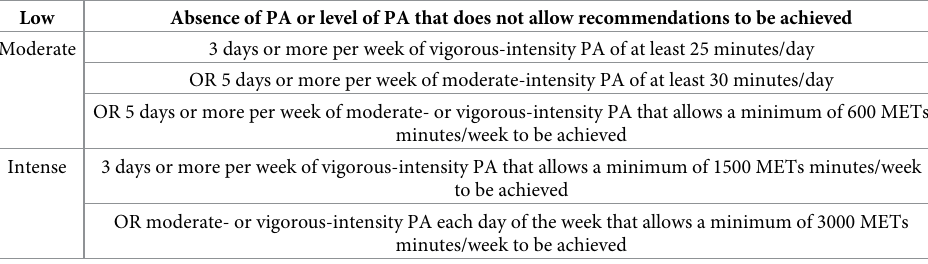
Table 1. Levels of physical activity from the WHO.